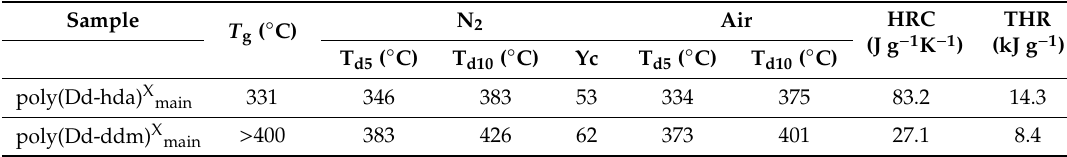
Figure 9. Total heat release (THR) versus temperature for poly(Dd-hda) X main and poly(Dd-ddm) X main . Table 2. Thermal and flame properties of polybenzoxazines.